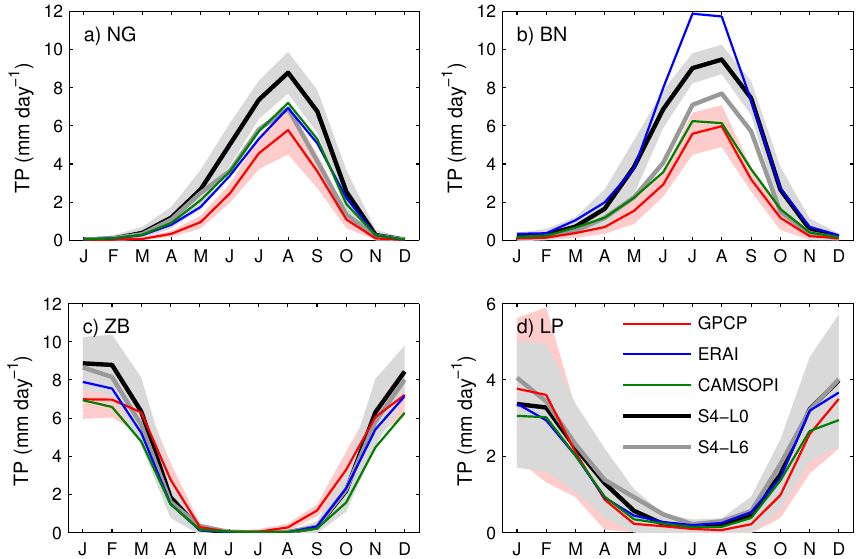
Fig. 3. Mean annual cycle of total precipitation (TP) over the selected basins. The shaded area represents the range ( ± 1 standard deviation) of observed (GPCP-red) and modelled (S4, grey) precipitation in the hindcast period (1981–2010), comparing with ERAI (blue) and CAMS- OPI (green). The time series for the seasonal forecasts uses the first (S4-L0, thick black) and last (S4-L6, tick grey) month of forecasts and the 15 ensemble